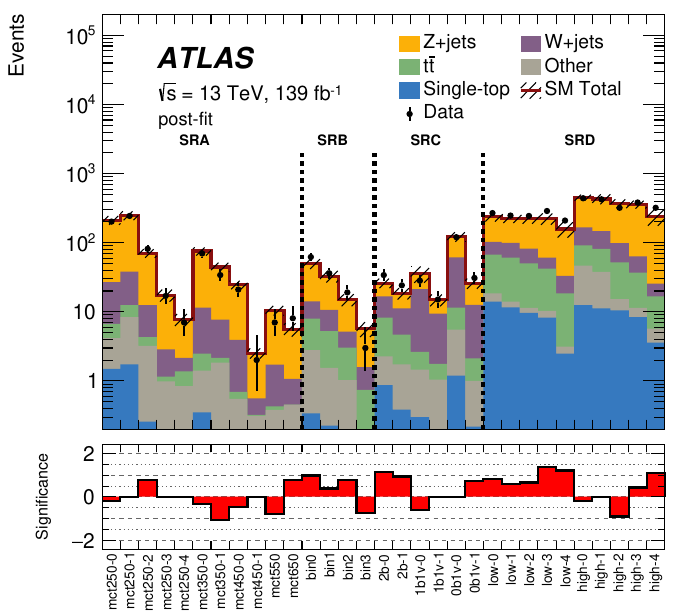
Figure 5 . Comparison between observed and background-only post-fit predicted background yields for the signal regions. The ratio plot represents the statistical significance of the discrepancy between the observed and predicted value. The “Other” category includes contributions from diboson and t ¯ t + W/Z/H production. The shaded band represents the total uncertainty of the background prediction. Where present, the last digit in the signal region name labels the bins of m for SRA, eff for SRC and cos θ ∗ for w XGB for SRB, E miss T bb